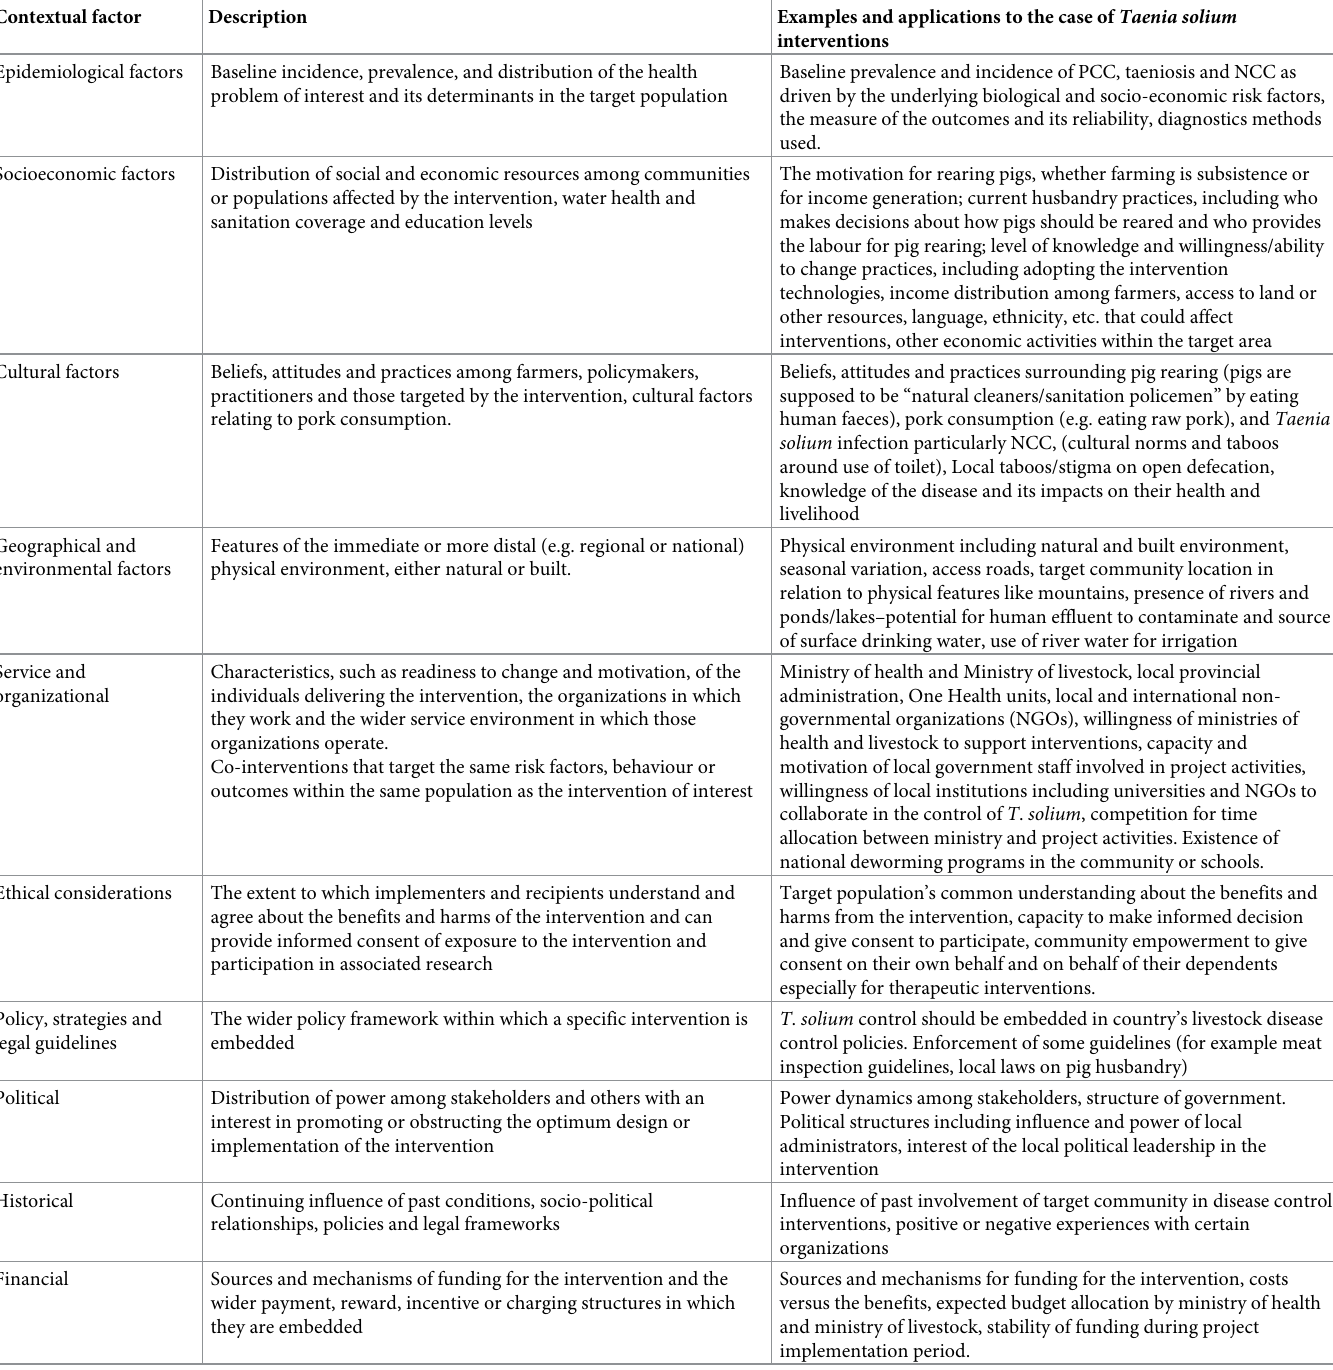
Table 1. A synthesis of the contextual factors for Taenia solium control interventions adapted from Craig et al.